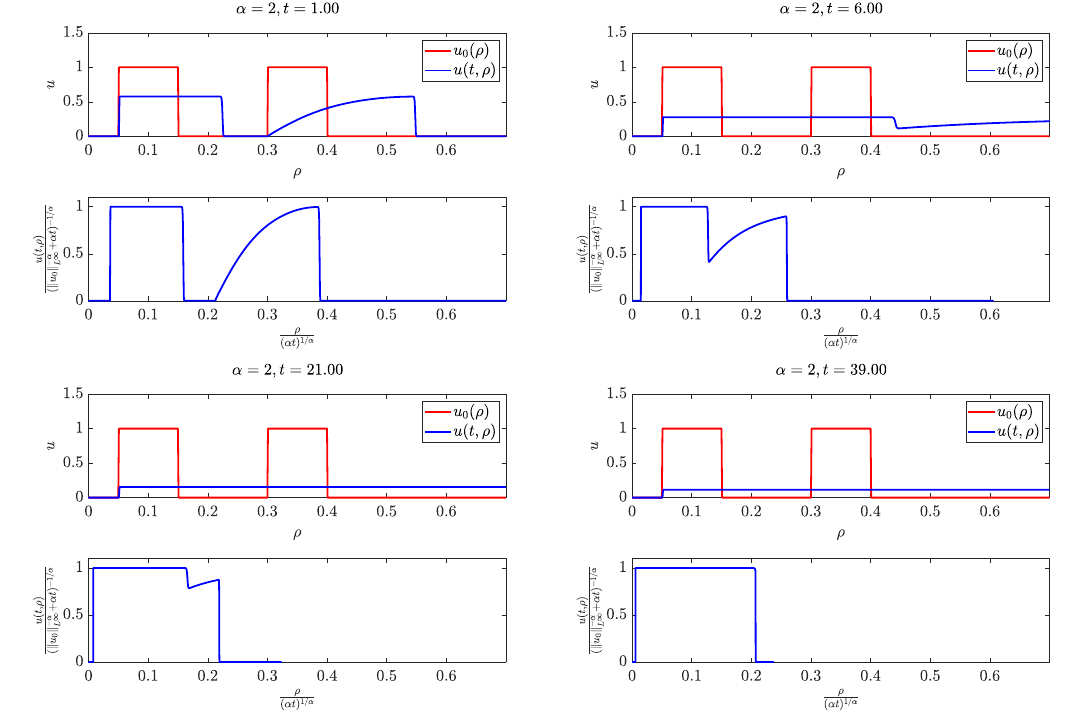
Fig. 7: Asymptotic behaviour of u in rescaled variables. See a movie simulation in the supplementary material [1, Video 3].